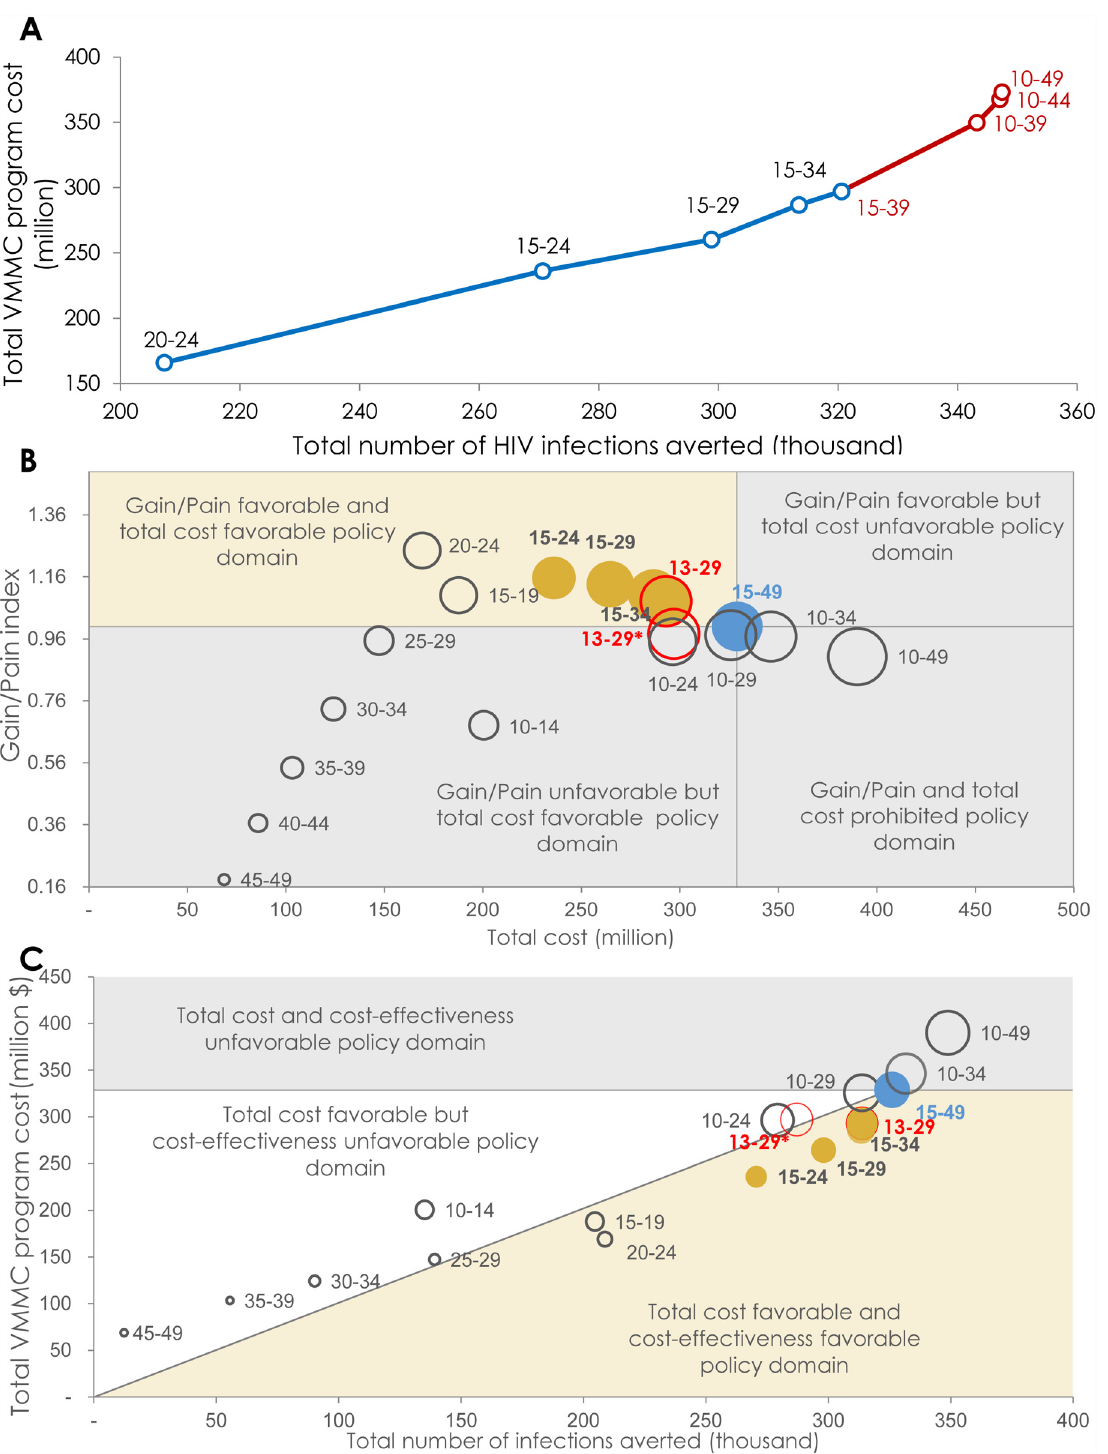
Fig 2. Program efficiency and policy domains of age-group prioritization in the voluntary medical male circumcision (VMMC) program. A) Expansion path curve showing the incremental change in total cost of the VMMC program ( program cost ) relative to the incremental change in total number of HIV infections averted ( magnitude of impact ) for each age group- targeted scenario. The blue line shows the expansion of the program with minimal diminishing of returns, and the red line shows the expansion of the program with considerable diminishing of returns. B) Frontier policy plot delineating the different policy domains based on the theme of maximizing program efficiency (maximizing gain while minimizing cost). Circle size represents the total